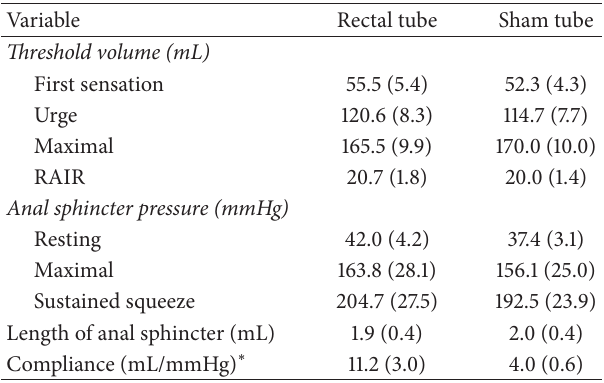
Table 2: Anorectal function in all subjects after